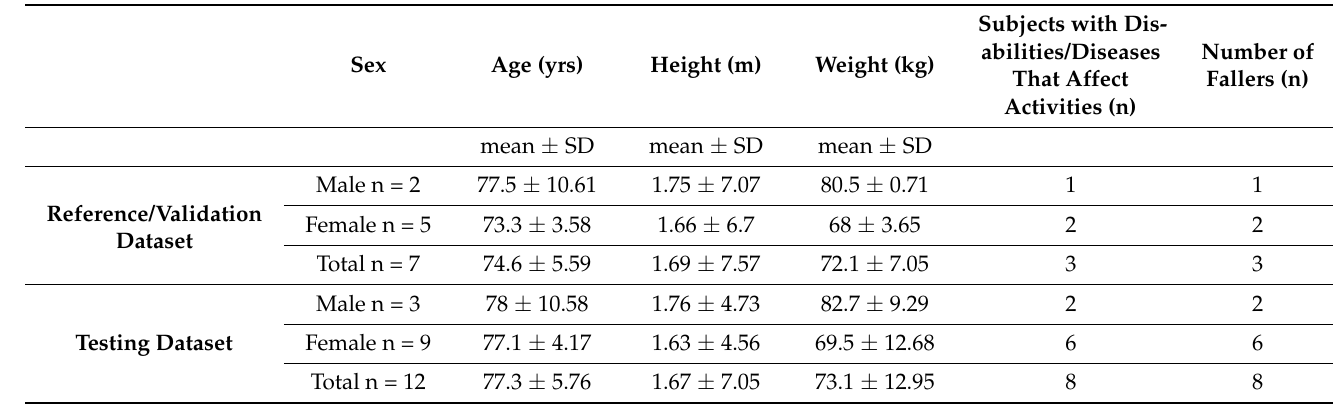
Table 3. Anthropometric data of subjects.